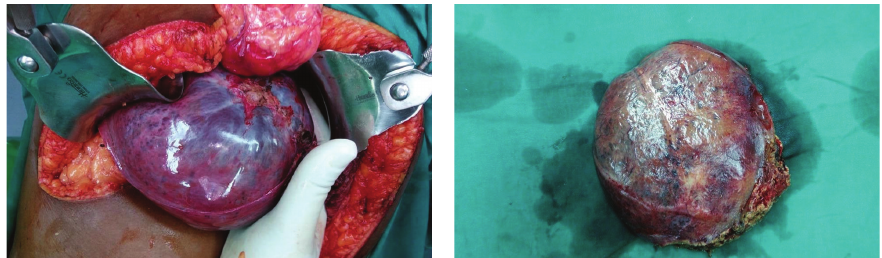
Figure 2: Intraoperative picture of hemangioma.